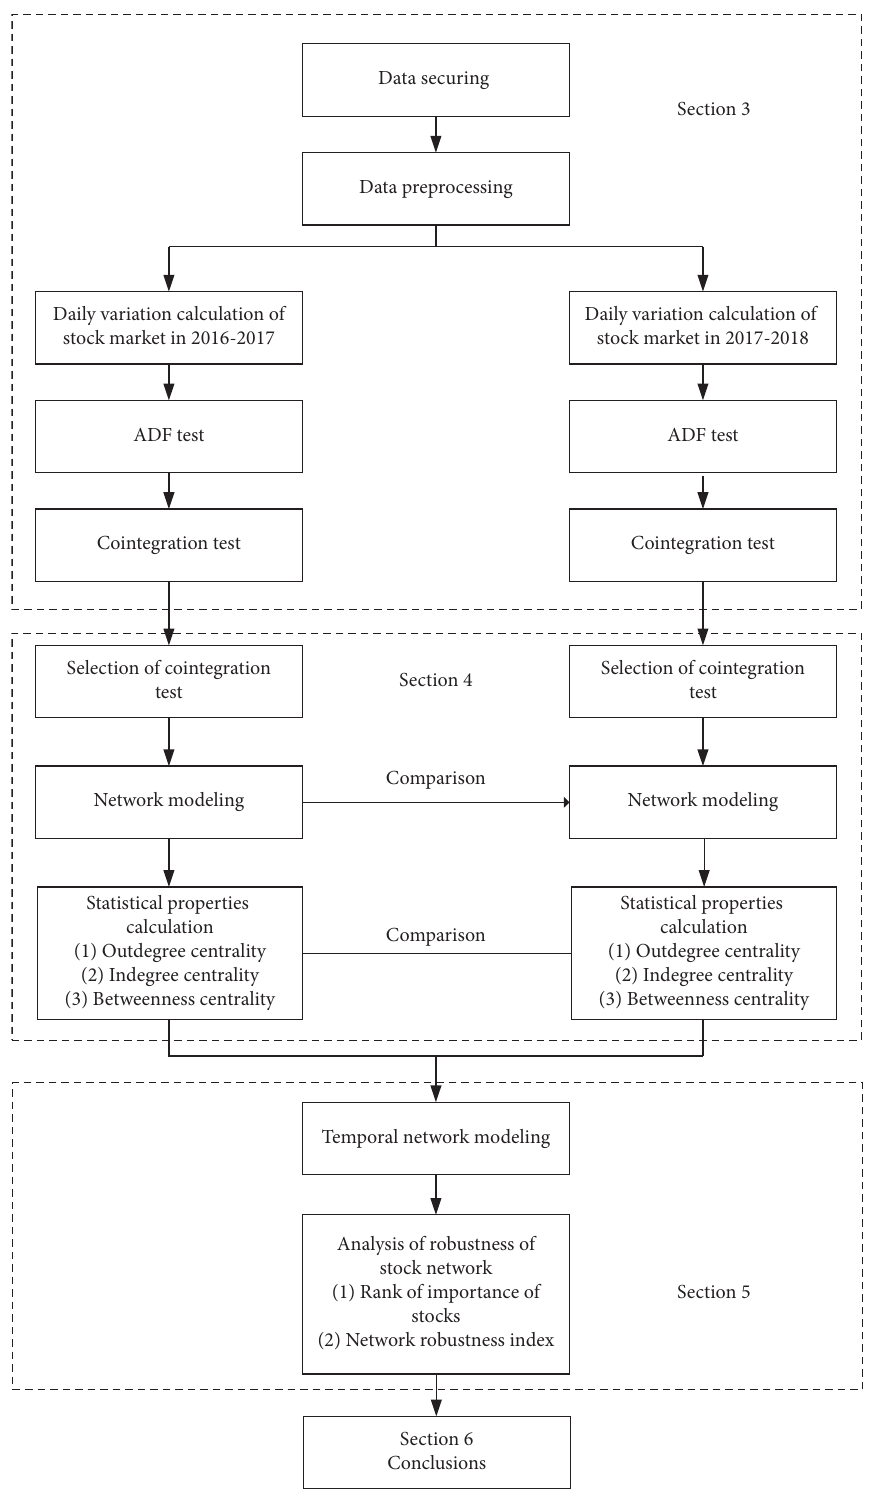
Figure 1: Research